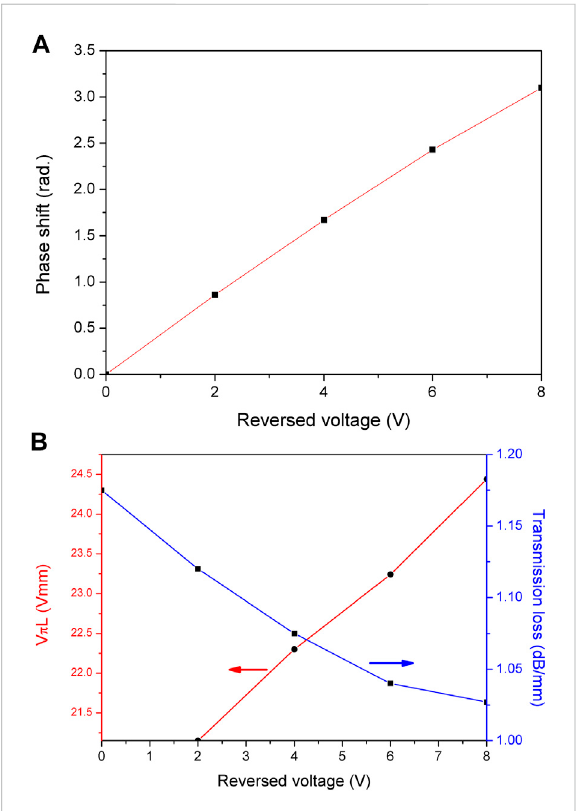
FIGURE 3 (A) The extracted phase shift as a function of the reversed voltage. (B) The transmission loss and V π L as functions of reversed